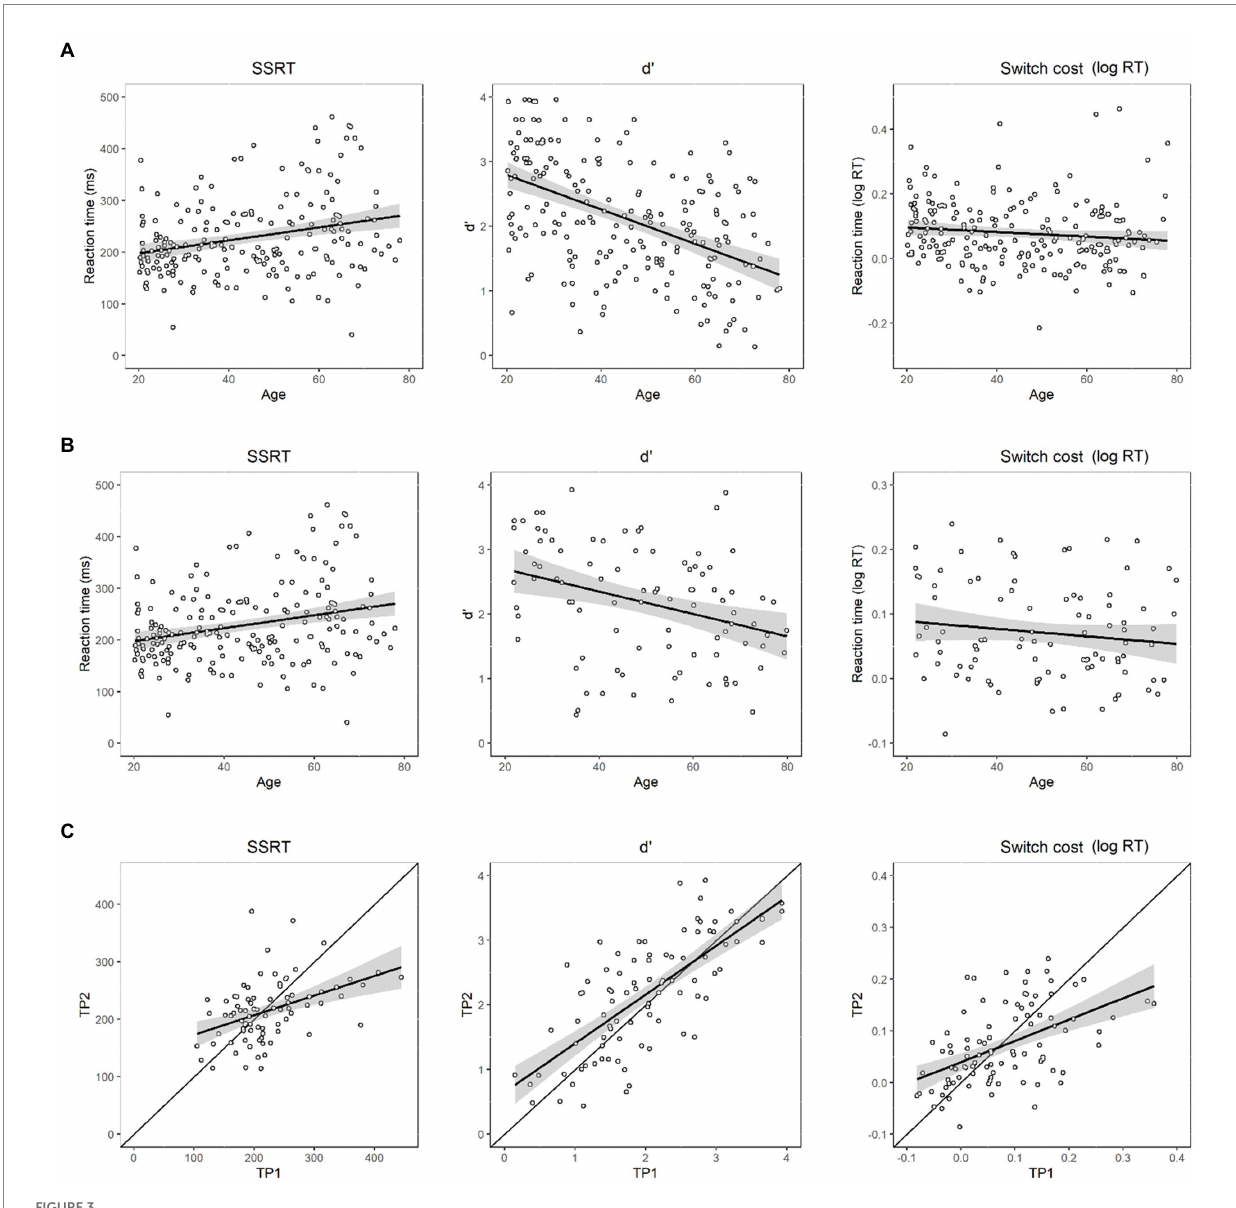
FIGURE 3 Linear effects of age on the efficiencies of the three tasks’ performance. (A) In the baseline session: left panel: Linear effects of age on stopping efficiency (SSRT: stop-signal reaction time); middle panel: Linear effects of age on 2-back sensitivity (d’); right panel: linear effects of age on switch cost (log-transformed RT); (B) In the follow-up session: left panel: Linear effects of age on stopping efficiency; middle panel: Linear effects of age on 2-back sensitivity (d’); right panel: linear effects of age on switch cost; (C) Modified Brinley plots for SSRT (left panel), d’ (middle panel), and switch cost (right panel). The X -axis denotes baseline, and Y -axis denotes follow-up. Scatterplots denote each data point for each individual. The best-fitting regression lines with standard deviations are shown against the diagonal